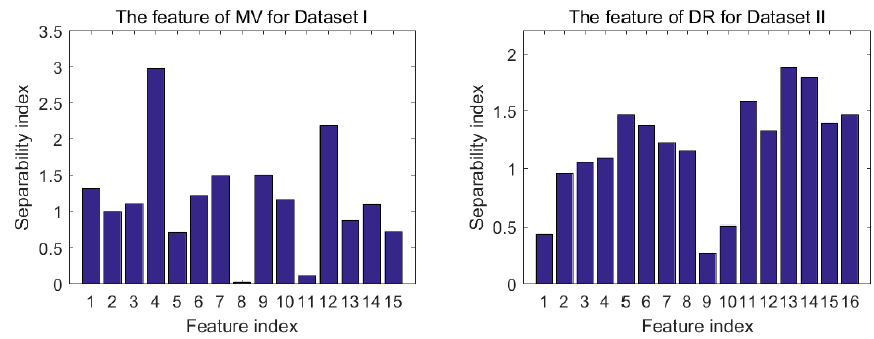
Figure 2. Separability index of maximum value (MV) for Dataset I and difference of the maximal resistance change and the baseline (DR) for Dataset II.